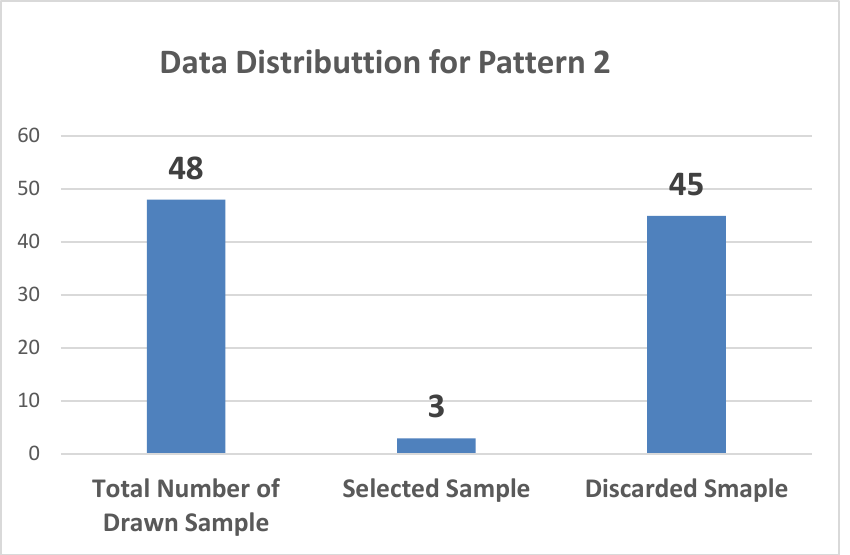
Figure 2: Data Distribution for Pattern